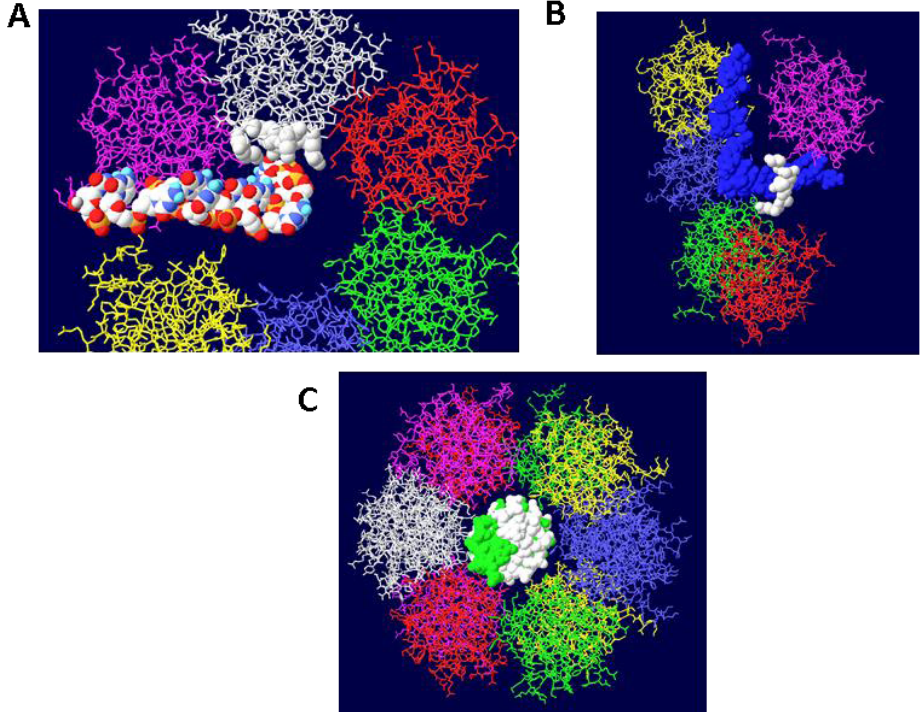
Figure 3. DNA in the channel of the OBD hexamers. ( A ) A single OBD hexamer is shown with its central channel in the middle. Single stranded DNA is shown to transit into the central channel, pass by four critical residues for DNA unwinding (white) and is threaded through the gap generated by the two terminal OBD monomers (purple and yellow). ( B ) A side view of a similar structure showing single stranded DNA passing within a trough generated by the four residues. ( C ) Face-on view of an OBD DH with double stranded DNA going through the central